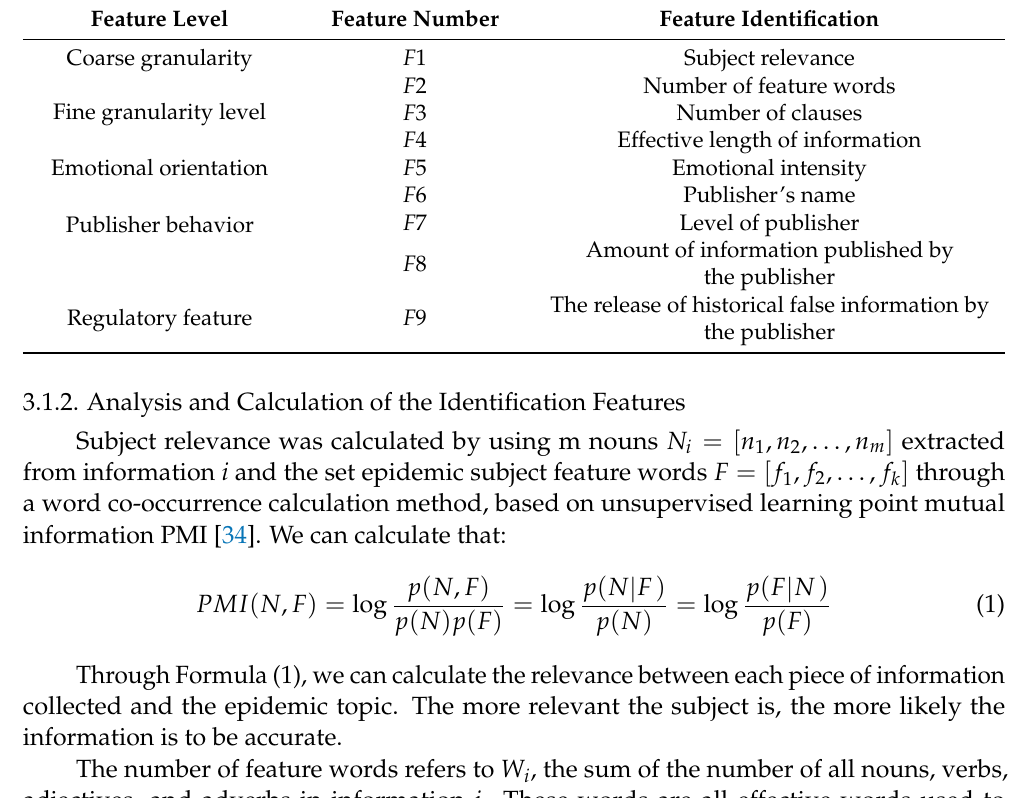
Table 1. Identification features of false epidemic